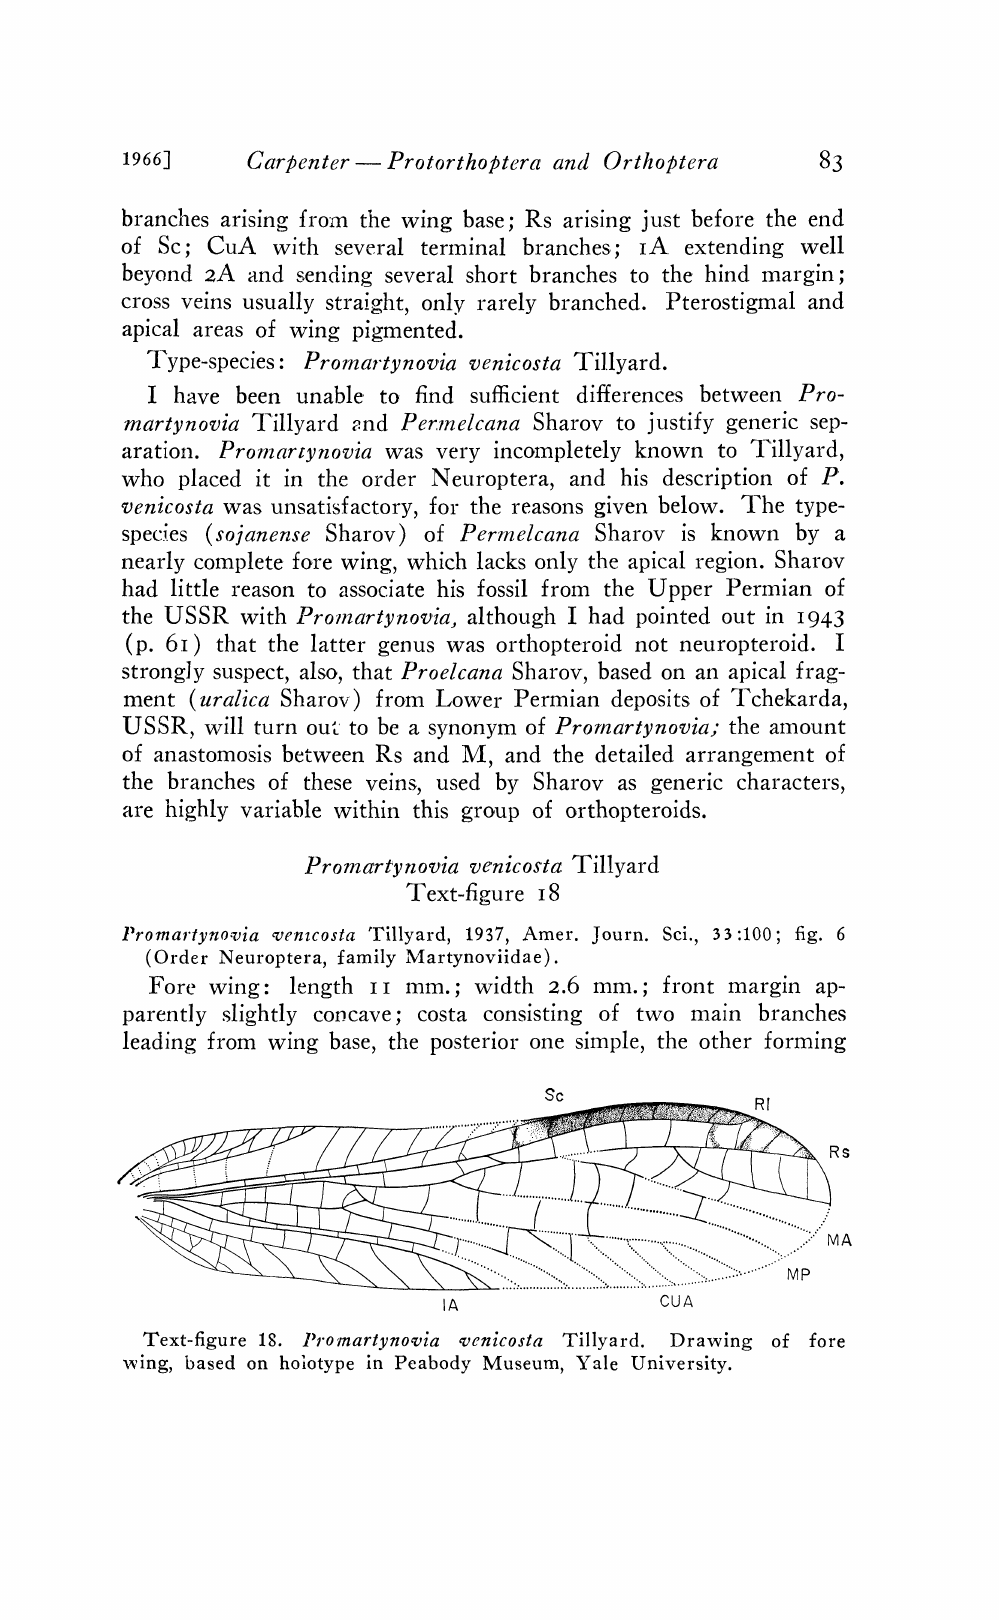
Text-figure 18. l’romartynoia enicosta Tillyard. Drawing of fore w’ing, based on holotype in Peabody Museum, Yale